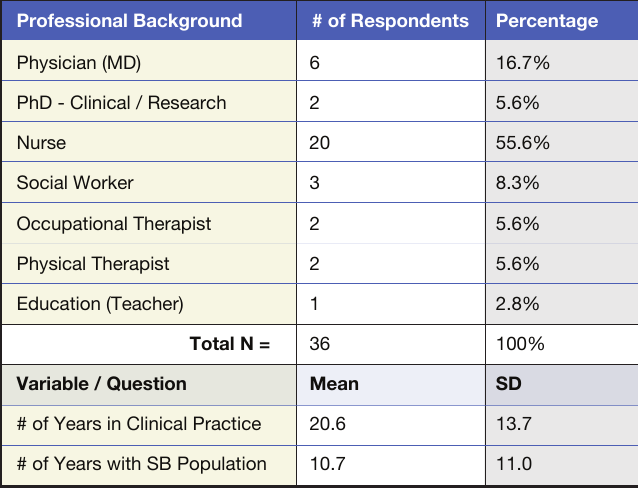
Table 1: Demographic Descriptive Statistics of Clinician